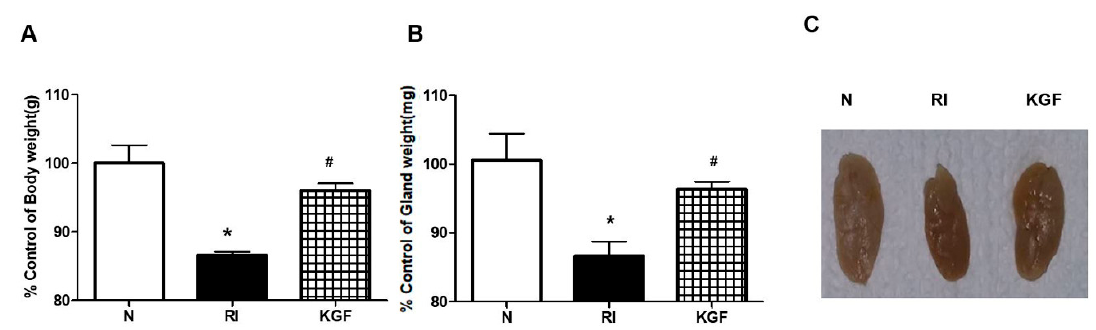
Figure 1. Effect of KGF-1 on salivary gland’s size and weight. ( A ) Body weights in the RI+KGF-1 group were significantly higher than in the RI group. ( B , C ) SG weights and sizes were also higher in the RI + KGF-1 group than in the RI group. Results are presented as means ± SDs; *, vs. treatment naïve controls; # , vs. the RI group. * p < 0.05, # p < 0.05 ( n = 6 mice per group) (N; treatment naïve controls, RI; the RI group, KGF; the RI + KGF-1 group).